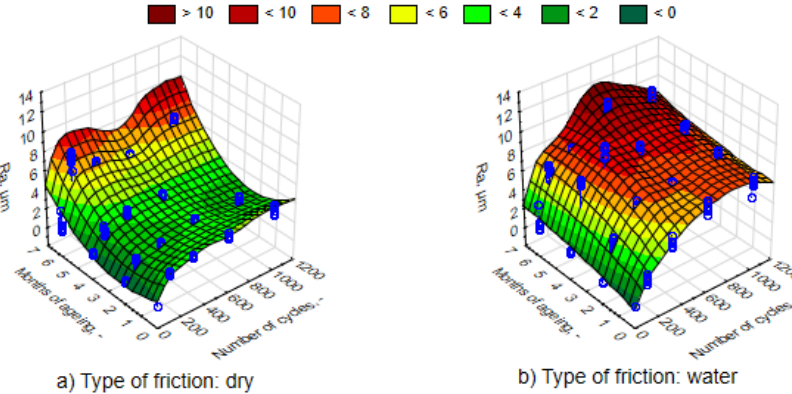
Figure 10. Characteristics of changes in parameter Ra, depending on the number of friction cycles, for samples in different phases of weathering, ( a ) dry friction, ( b ) wet friction.